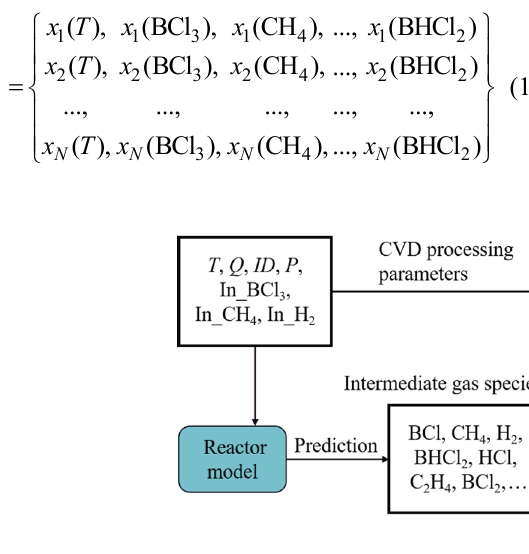
Fig. 2 ML model design for B / C